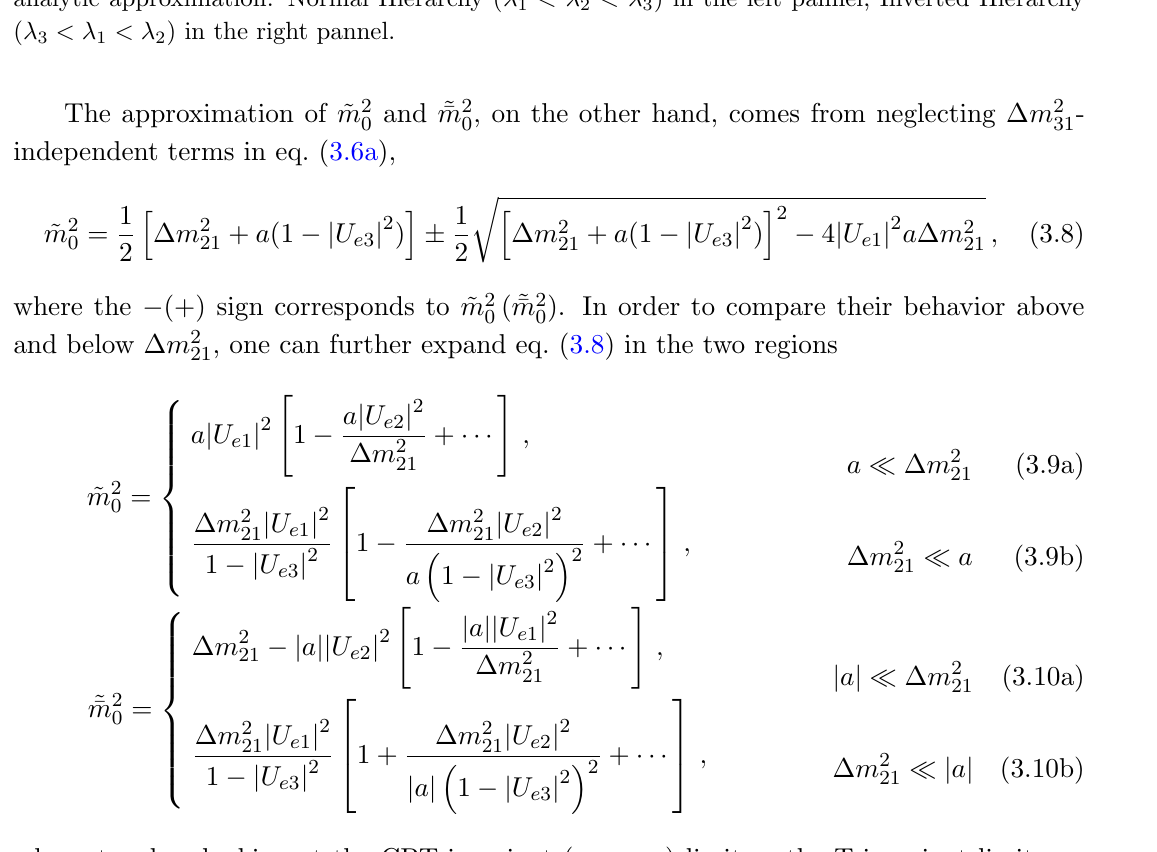
Figure 1 . Eigenvalues (cid:21) i of the mass matrix in matter in units of (cid:1) m 2 ( a > 0) and antineutrinos ( a < 0). The horizontal axis shows both the evolution of the matter parameter a at (cid:12)xed energy (lower labels), i.e. changing the matter density, and as function of the energy if the constant density is chosen as that of the Earth mantle (upper labels). Both the exact (dashed) and the analytical (solid) results from eqs. (3.6) are shown to illustrate the excellence of the analytic approximation. Normal Hierarchy ( (cid:21) 1 < (cid:21) 2 < (cid:21) 3 ) in the left pannel, Inverted Hierarchy ( (cid:21) 3 < (cid:21) 1 < (cid:21) 2 ) in the right pannel.